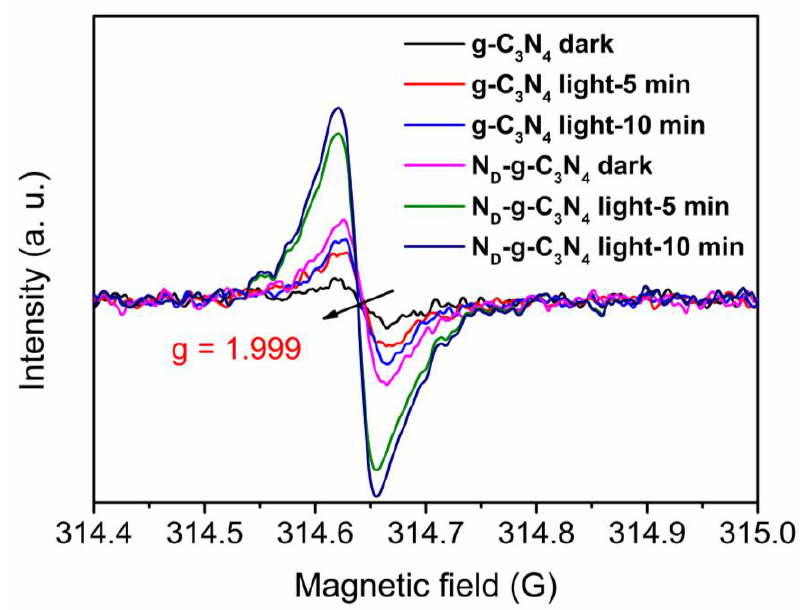
Figure 3. EPR spectra of the samples under dark and light irradiation for 5 min and 10 min at room temperature showed a g value of 1.999.